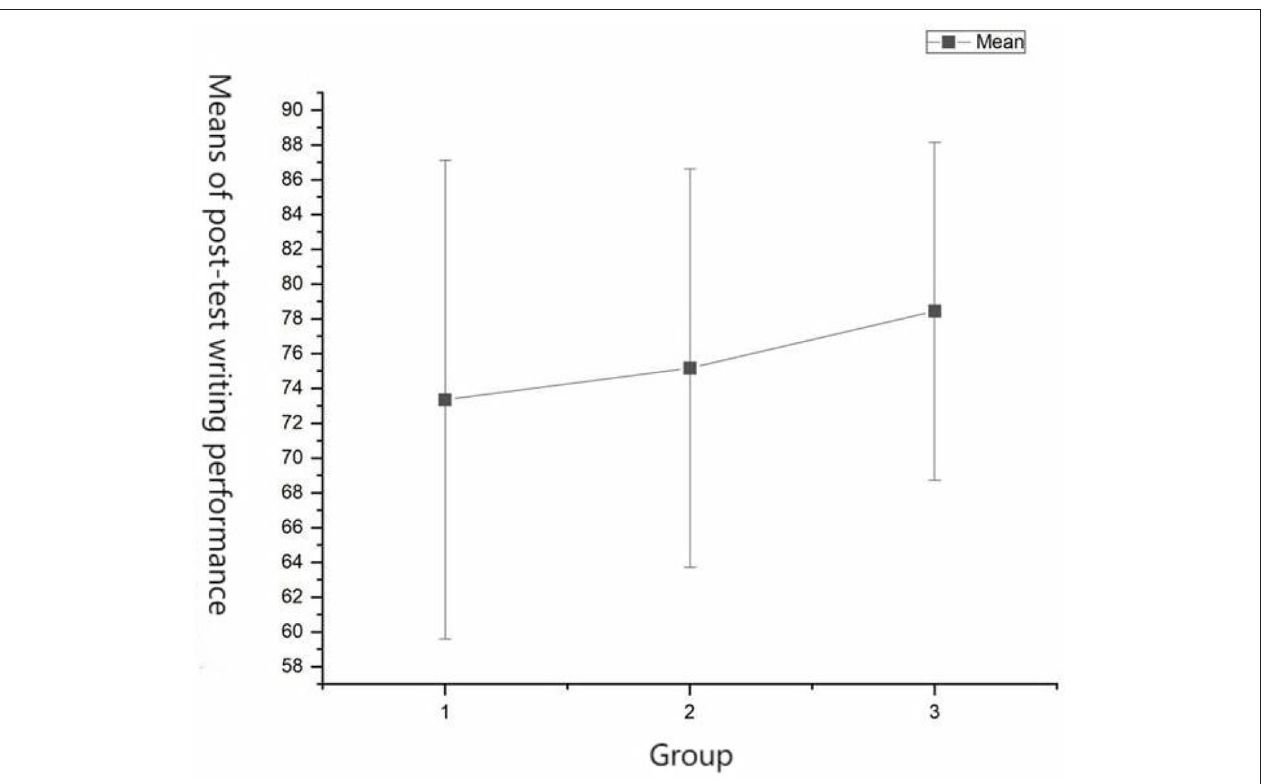
FIGURE 7 | Means plot of post-test writing performance.